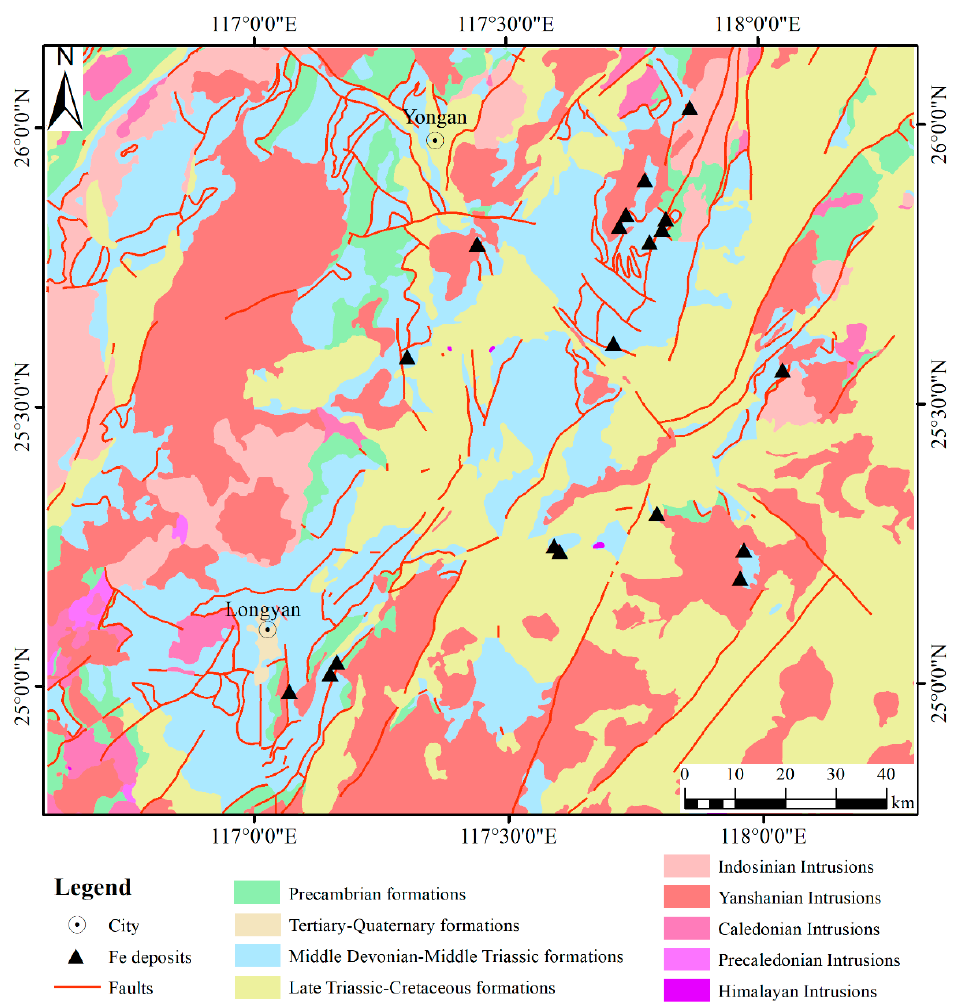
Figure 2. Simplified geological map of the southwestern Fujian metallogenic belt (modified from Zuo [30]).